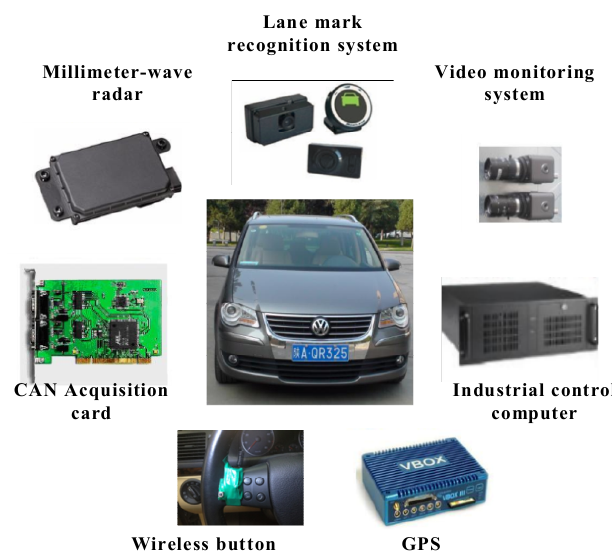
Figure 1. The test Figure 1. The test vehicle.